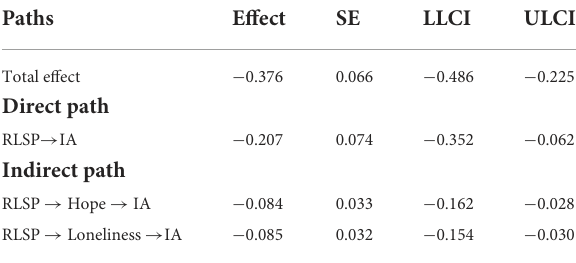
TABLE 4 Direct and indirect effects of social support via hope and loneliness on internet addiction.